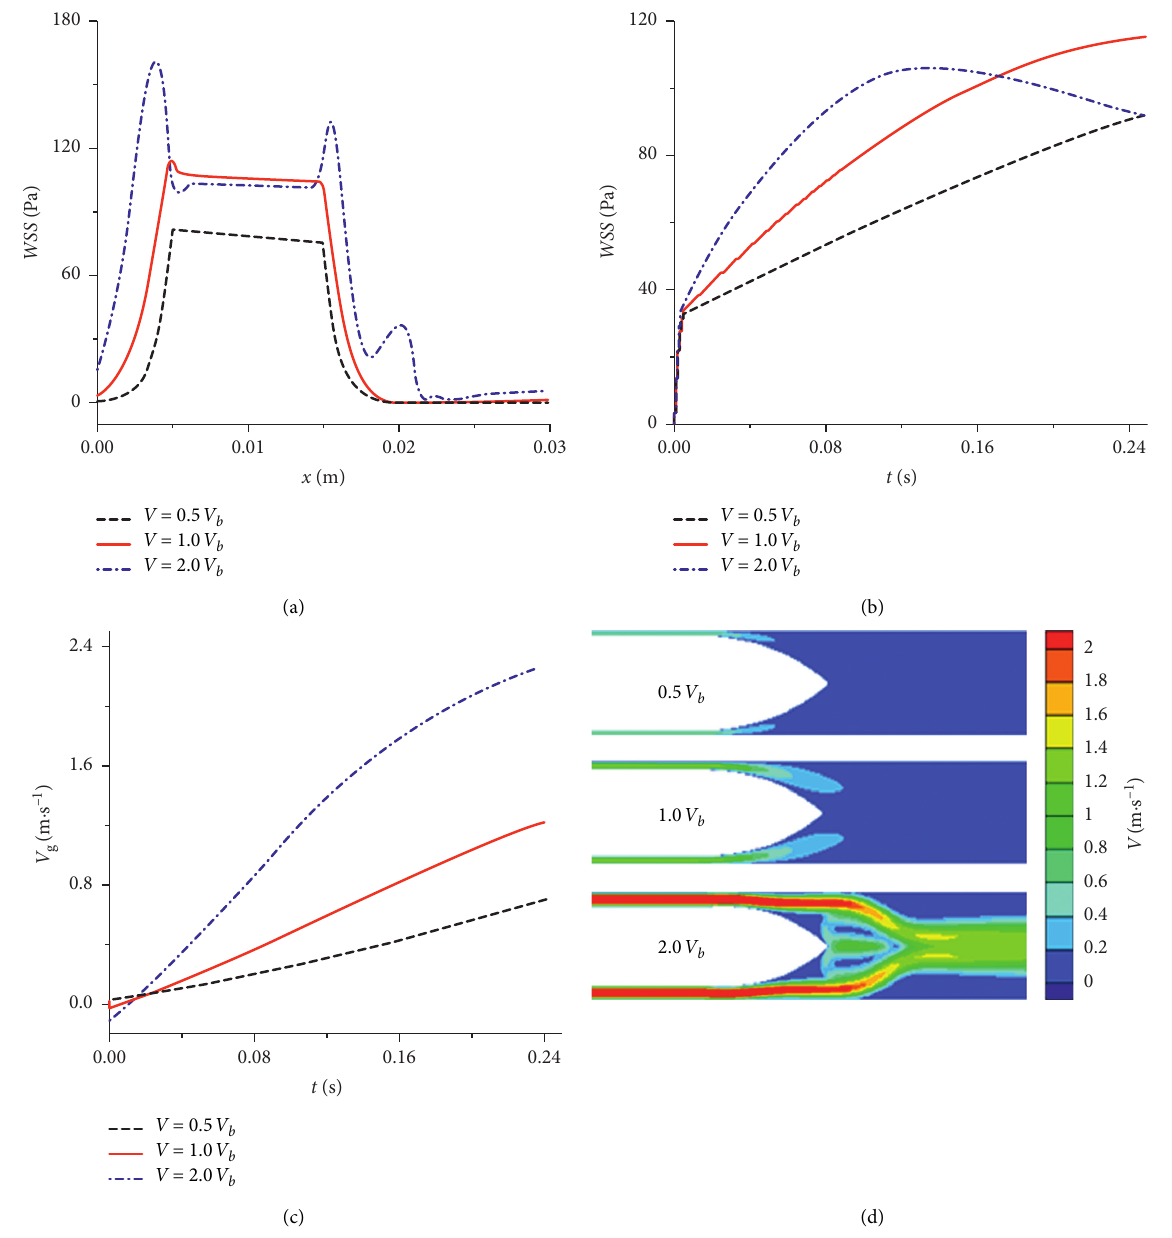
Figure 4: Comparisons of simulated flow velocities and vascular wall shear stress (WSS) under various balloon deflation velocities. (a) Simulated vascular WSS with the fluid and perfusion pressure along the balloon; (b) simulated vascular WSS in the balloon area under different velocity of balloon deflation; (c) simulated flow velocity in the balloon-vessel gap under different velocity of balloon deflation; (d) simulated flow velocity contour maps under different velocity of balloon